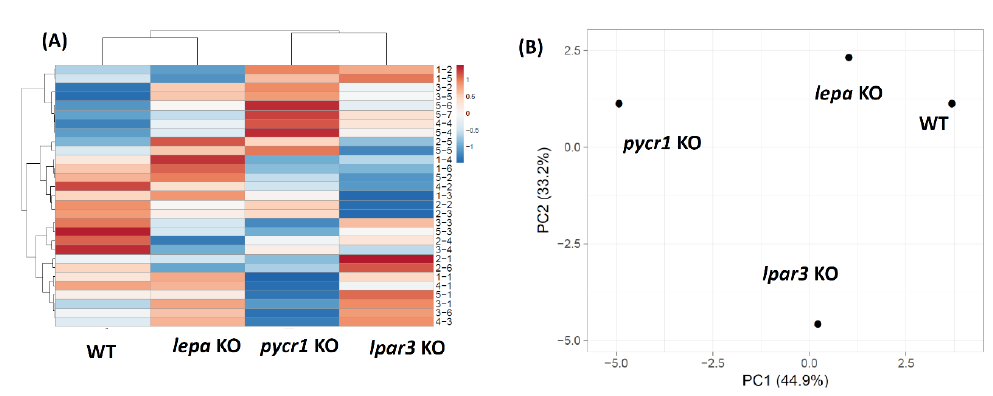
Figure 8. ( A ) Hierarchical clustering analysis and ( B ) principal component analysis (PCA) of multiple behavior endpoints in lpar3 KO fish. In addition, other mutant zebrafish behavioral data from previous publications of lepa KO and pycr1 KO fish were included to compare the behavior alteration patterns of each mutant fish group. WT, wild-type fish.